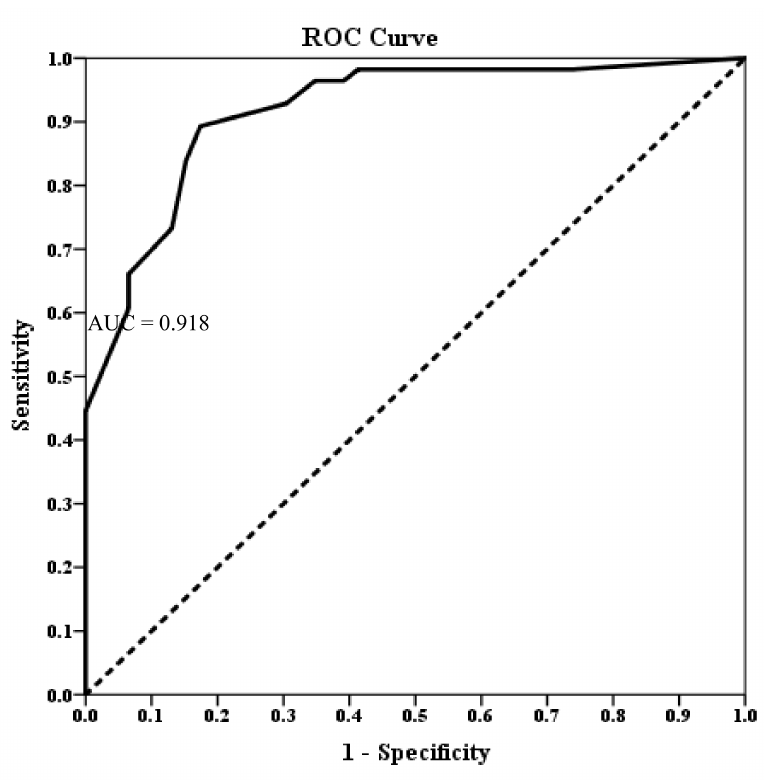
Figure 2. The receiver operating characteristic (ROC)